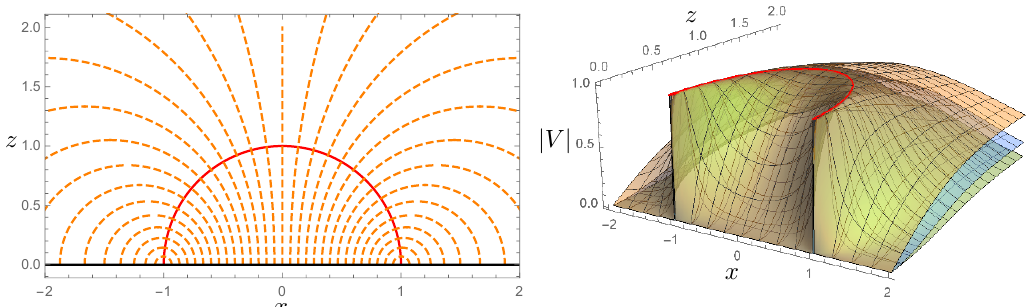
Figure 2 . Vector lines and magnitude j V j for a sphere in d = 1 (orange), d = 2 (blue) and d = 3 (green) spatial dimensions, respectively. The vector (cid:12)eld V exhibits spherical symmetry so, for simplicity, we have plotted only one of the spatial axis in all case. The solid red line corresponds to the minimal surface, m ( A ). This curve also signals the location where the magnitude of the vector (cid:12)eld attains its maximal value, j V j =